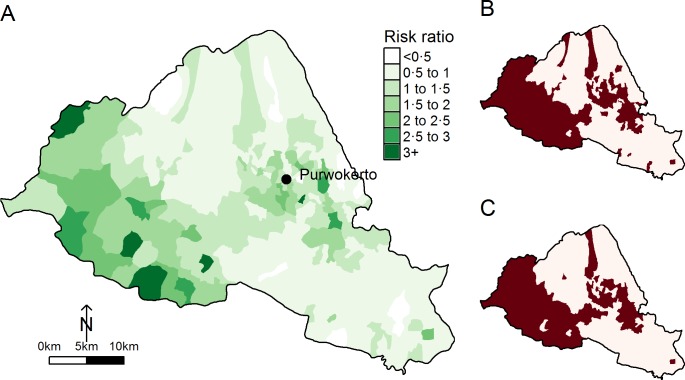
Adjusted village-level risk of dengue for the period 2000–2013.(A) Map of the spatial pattern of the unexplained risk for dengue infection, as identified in Model 1. The risk ratio takes the value one if no deviation exists between the model’s inferences based on the included, known risk factors and observations. Values of less than 1 (white and lightest shade of green) indicate villages that have a lesser risk of infection than predicted, whereas the darker shade of green indicates villages for which the model did not account for all the risk of infection. (B) Distribution of the significant village-specific posterior probability of the spatial random effect for Model 1. (C) Distribution of the significant village-specific posterior probability of the spatial random effect for Model 2. Villages in dark red in (B) and (C) show villages where posterior probabilities p(exp(σi) > 1|y) > 0.8, indicating an excess risk of dengue with relatively small level of associated uncertainty.